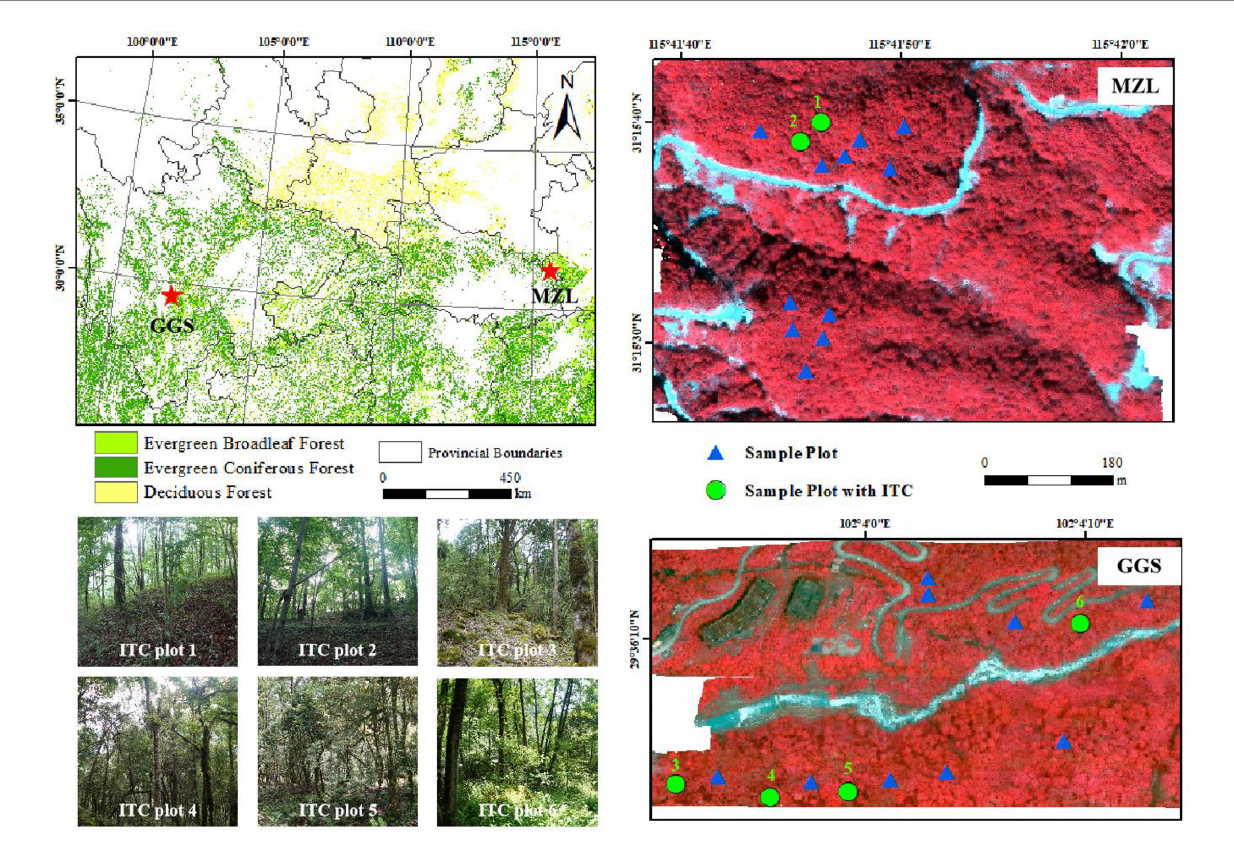
FIGURE 1 The location of two study areas (top left) with 10 m spatial resolution from ChinaCover2020 (Wu et al., 2017), and MZL study area (top right) and GGS study area (bottom right) with imaging spectroscopy data acquired from Cuber UHD185 Firefly imaging spectrometer (Red: 866 nm, Green: 654 nm, Blue: 566 nm). The blue triangles indicate the locations of field-measured sample plots. The green circles indicate the locations of individual tree crown (ITC) validation plots. Six photographs of these ITC plots are shown on the bottom